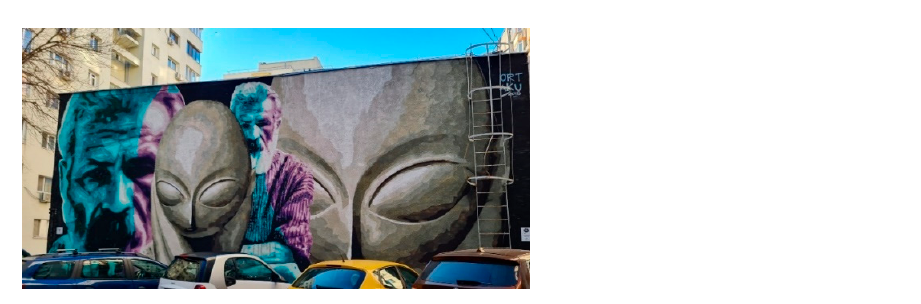
Figure 35. Brâncu ș i, Ș tefan cel Mare neighborhood, Bucharest by Ortaku, 2018 (photo taken in 2021).